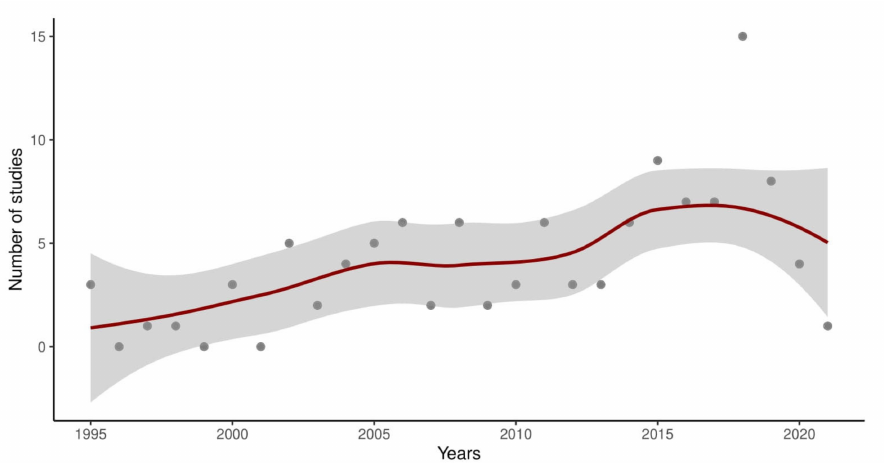
Figure 2. Graphical representation of the number of studies per year included in this systematic review. The scatter plot was established using the package Ggplot2 [12] of R studio